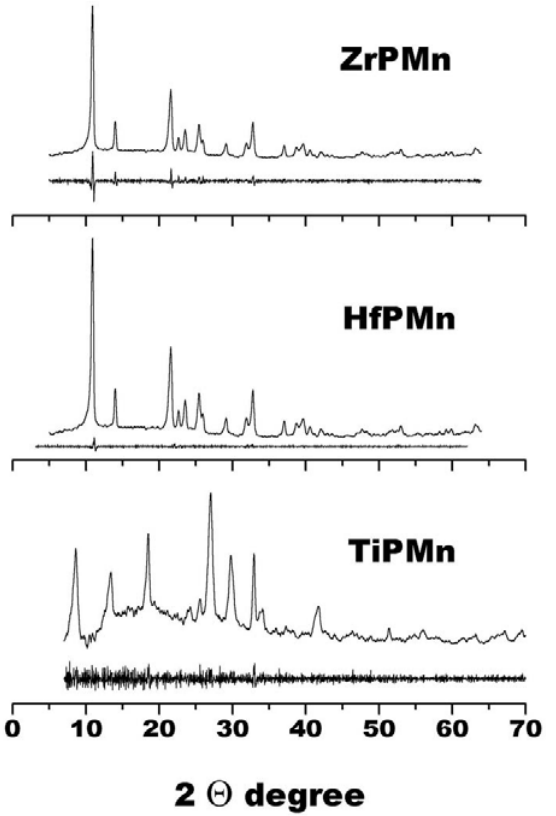
Fig. 4 The difference plot of Mn(II) containing phosphates (measured and